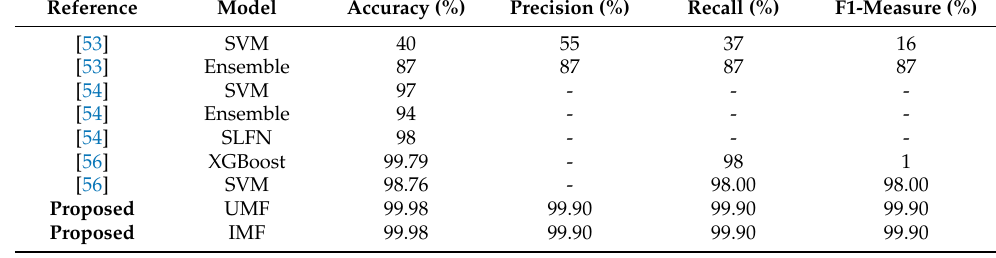
Figure 11. The comparison results of our detection model performance and related works of IoTID20.